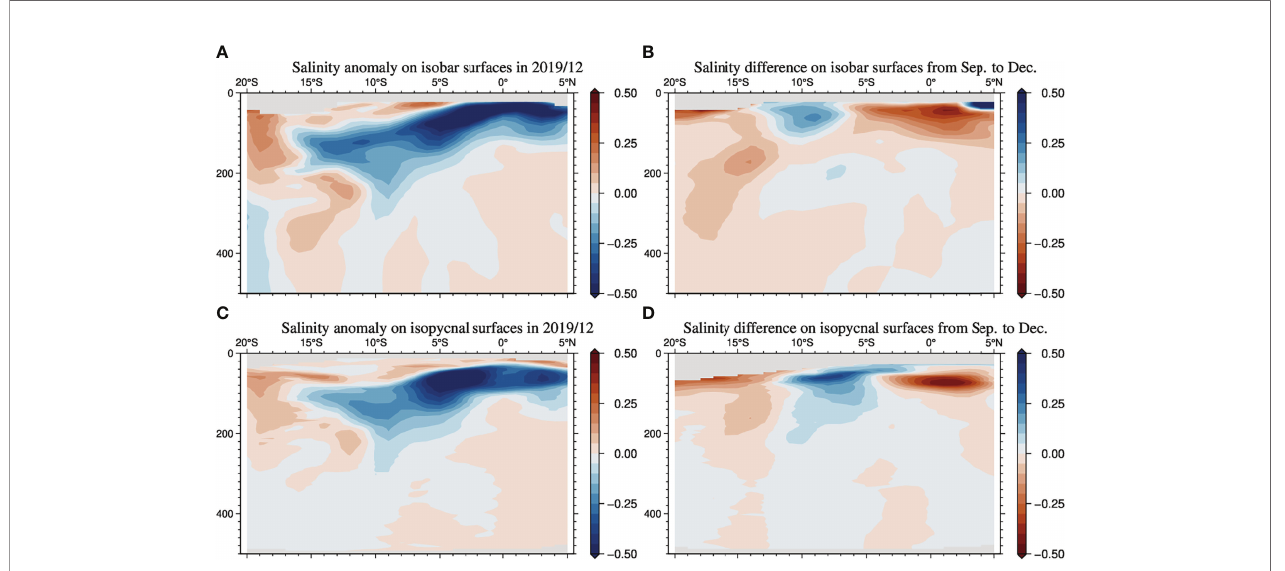
FIGURE 5 | Salinity anomalies on the isopycnal surfaces (A) and isobar surfaces (C) from monthly climatology (averaged over 2006 – 2020) along 80°E based on the Argo gridded dataset and differences in the climatological salinity based on the gridded dataset from September to December on the isopycnal (B) and isobar surfaces (D)